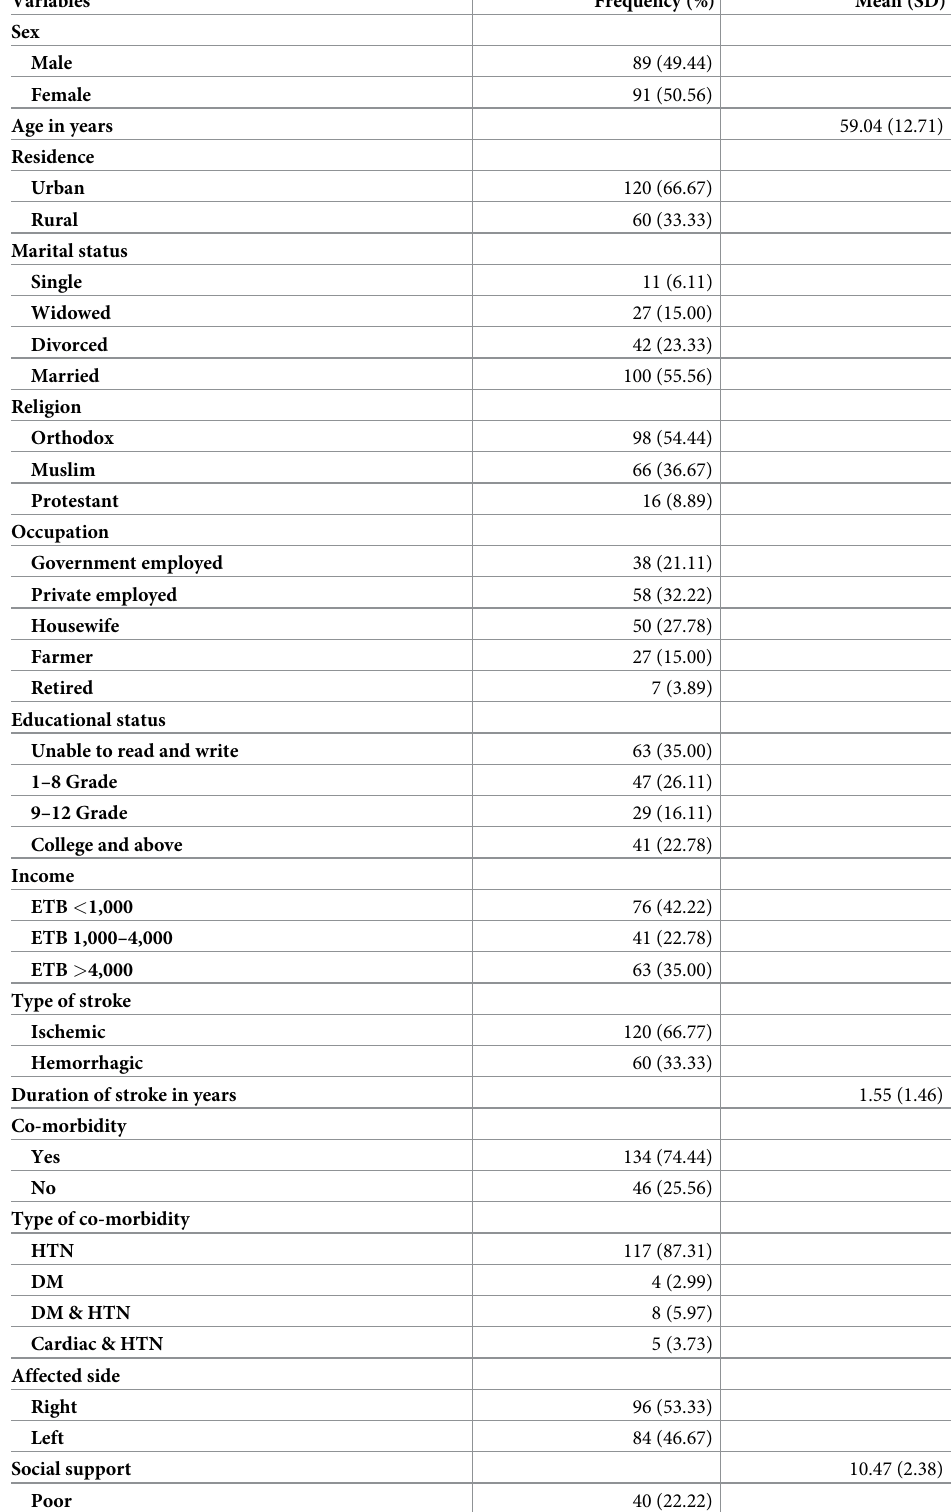
Table 1. Sociodemographic and clinical characteristics of study participants (N =